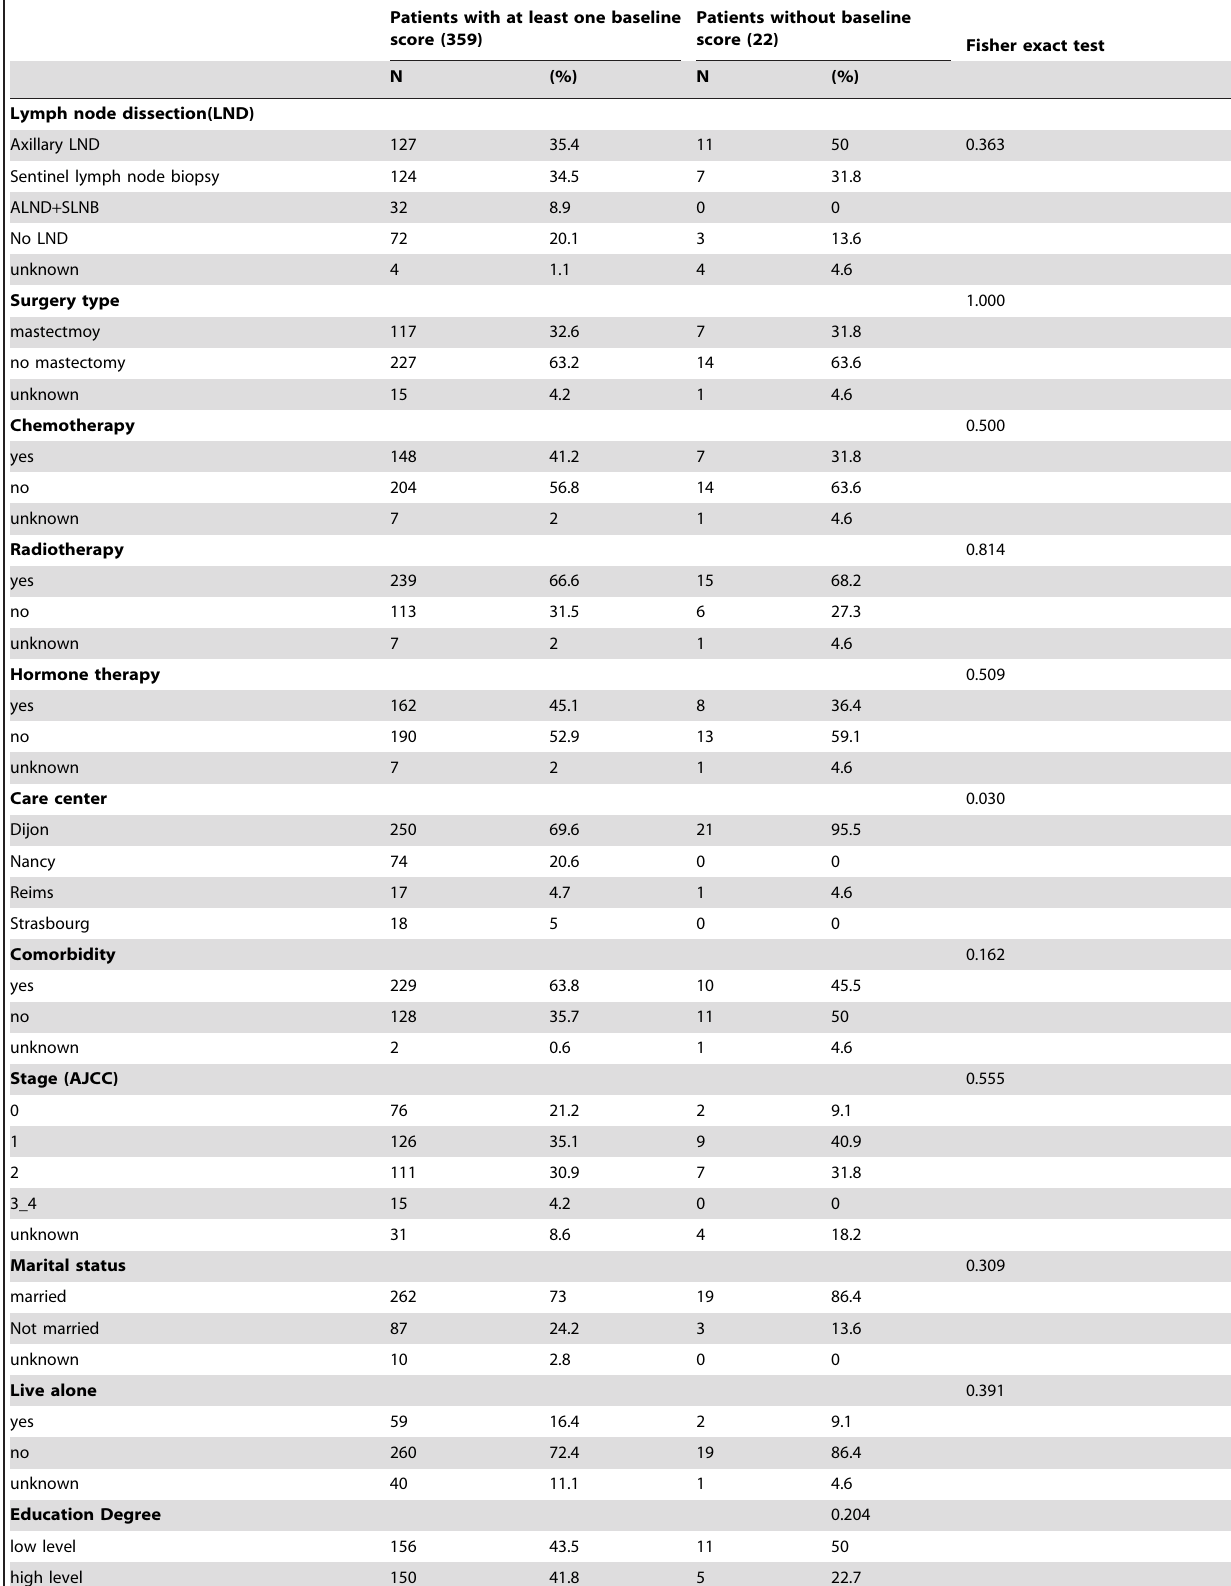
Table 1. Characteristics of patients according to the completion of quality of life questionnaire at